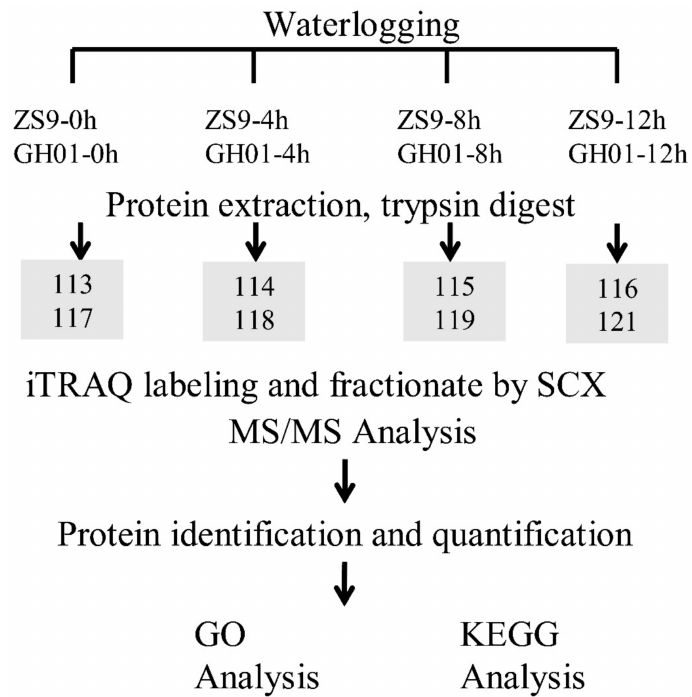
Figure 9. Experimental design of this proteomic study. After undergoing waterlogging stress for 0 h, 4 h, 8 h, and 12 h, the root of the germinated seed is sampled for protein extraction, trypsin digesting, and iTRAQ labeling. The iTRAQ-labeled samples are identified and quantified using the Easy-nLC Nanoflow HPLC system, and then identified proteins were taken for GO and KEGG analysis. Three biological replications are mixed equally for each iTRAQ